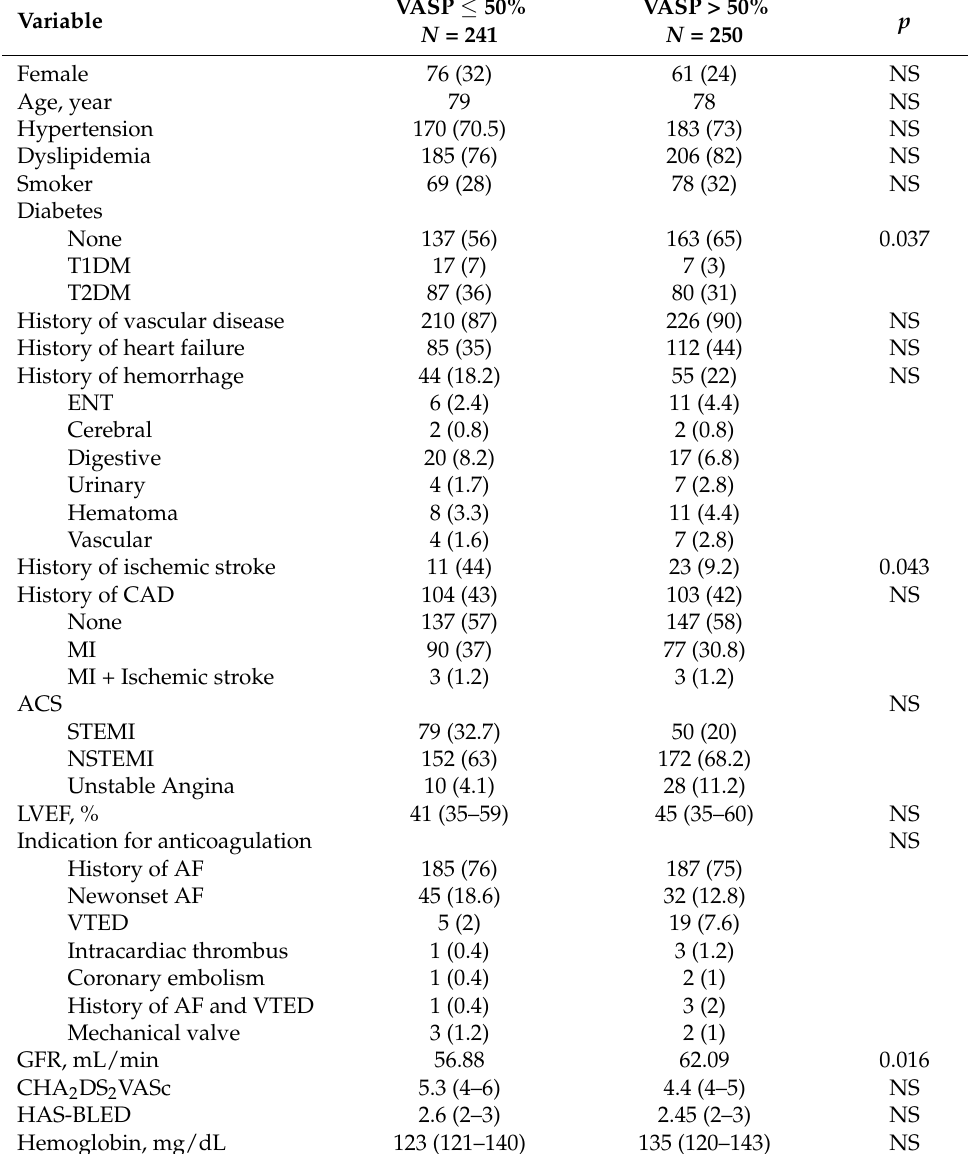
Table 3. Baseline characteristics for patients with 6 months follow-up, VASP cut-off 50% (N =